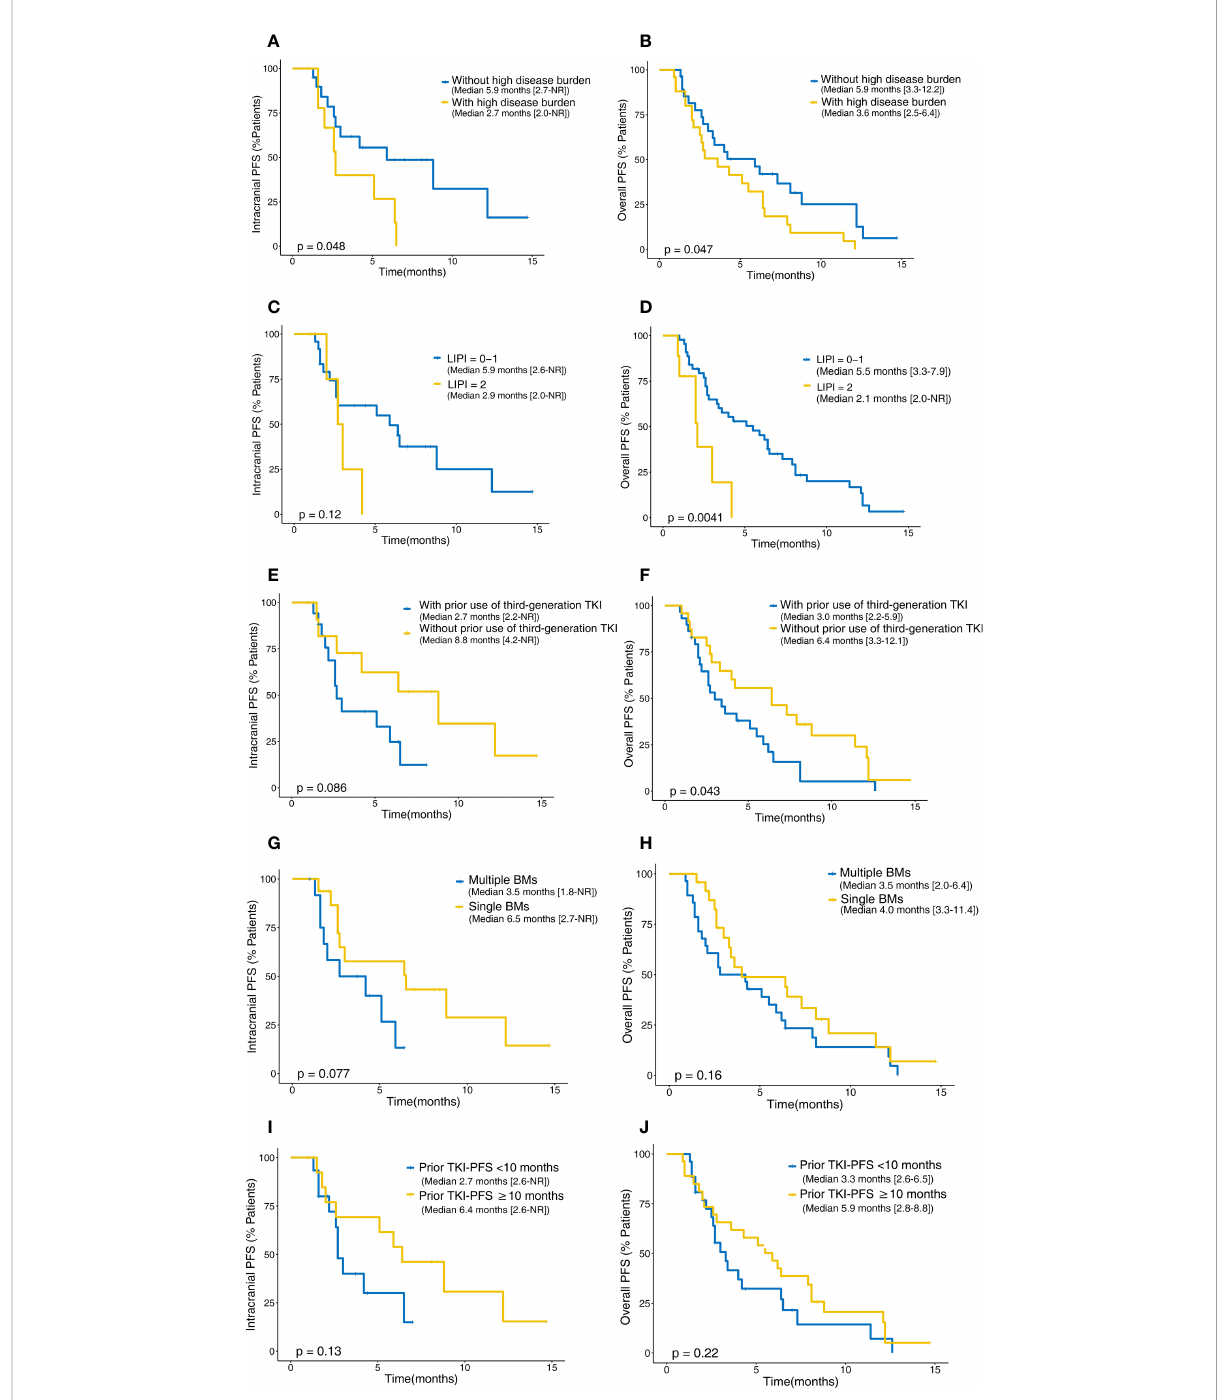
FIGURE 7 Kaplan – Meier analysis for intracranial and overall PFS in patients with different risk factors. Intracranial (A) and overall PFS (B) between patients with and without high disease burden. Intracranial (C) and overall PFS (D) between patients with and without poor LIPI. Intracranial (E) and overall PFS (F) between patients with and without prior usage of third-generation EGFR-TKI. Intracranial (G) and overall PFS (H) between patients with and without multiple BMs. Intracranial (I) and overall PFS (J) between patients with prior TKI-PFS <10 months and ≥ 10 months. PFS, progression-free survival; NR, not reached; LIPI, immune prognostic index; EGFR, epidermal growth factor receptor; TKI, tyrosine kinase inhibitor; BMs, brain